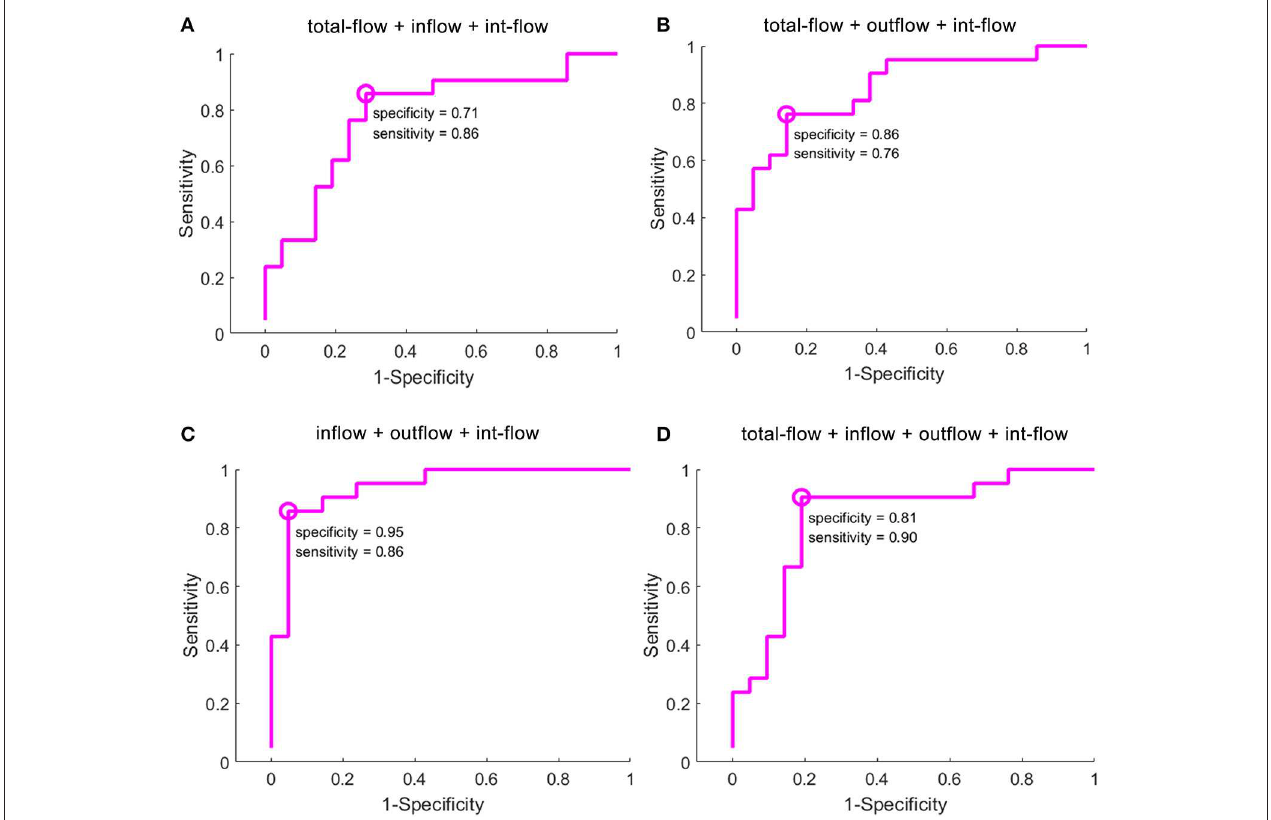
FIGURE 3 | Classification results of GCD maps using selection of the optimal feature dimensions of the SVM-RFE method. GCD, granger causality density; SVM, support vector machine; RFE, recursive feature elimination. The classification accuracy of the combination with total-flow, inflow and int-flow connectivity (A) , the combination with total-flow, outflow and int-flow connectivity (B) , the combination with inflow, outflow and int-flow connectivity (C) , and the combination with total-flow, inflow, outflow and int-flow connectivity (D)